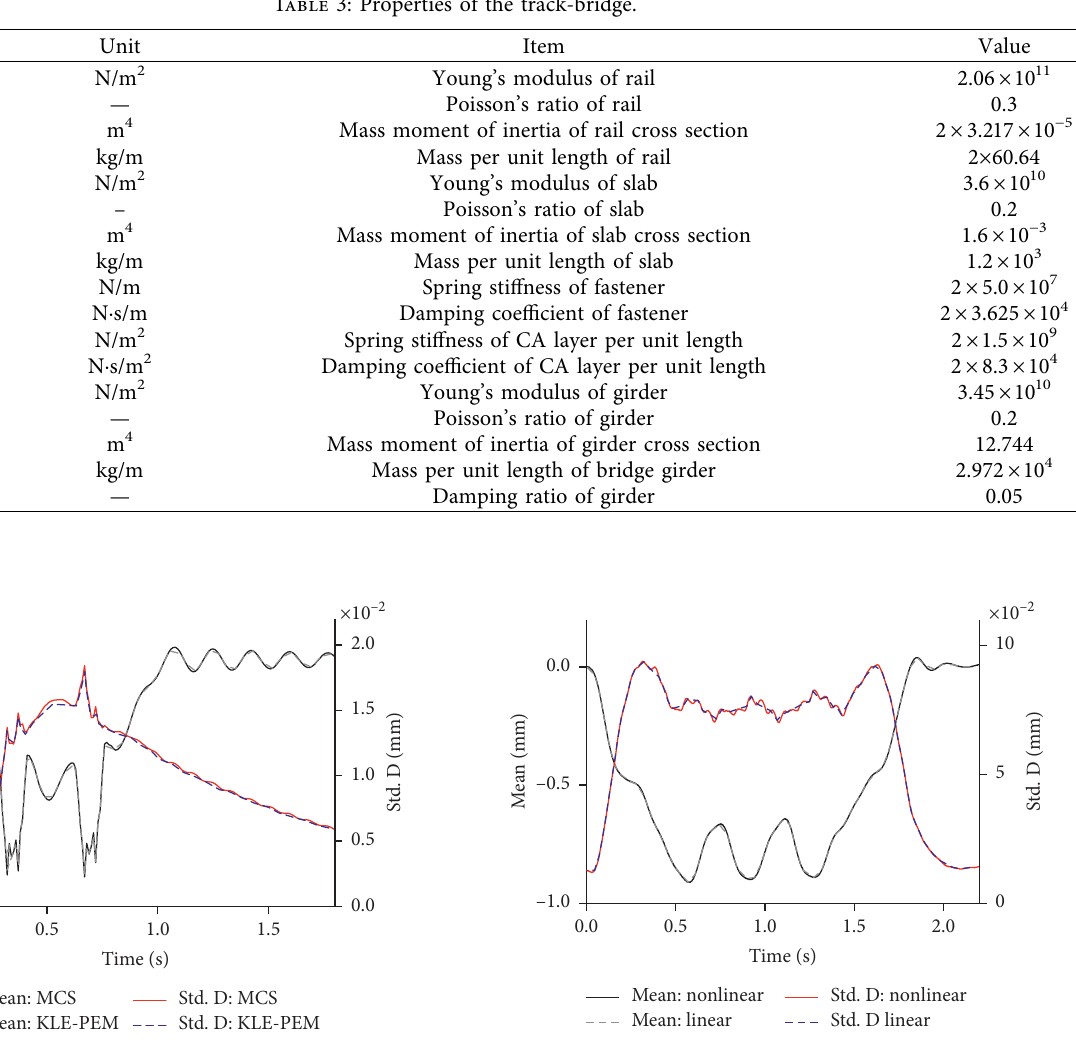
Figure 4: Comparison of displacement of fastener at midspan.